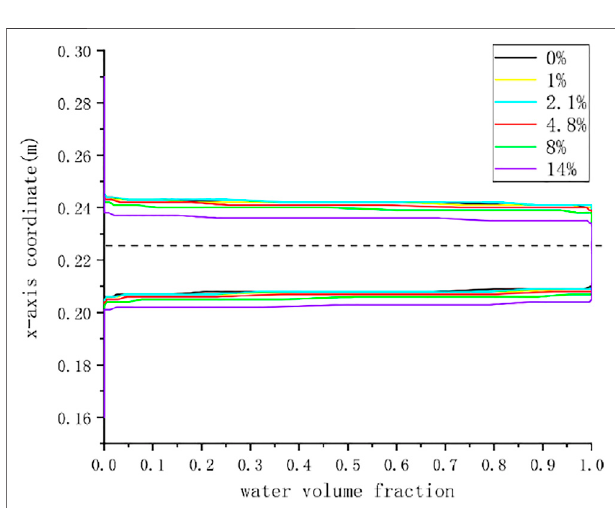
FIGURE11| Jetstateonthestraightlineofz=0 mmontherunnerinlet.